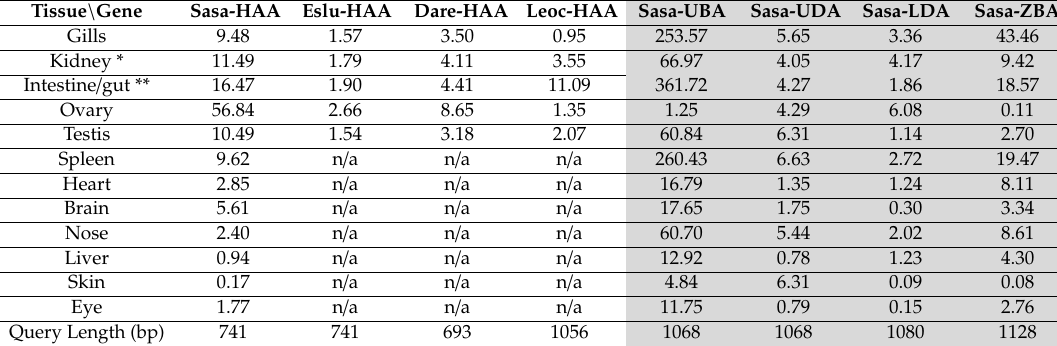
Table 1. HAA transcription in various tissues of several teleost fish species. Transcriptional values are given as RPKM, i.e., Reads Per Kilobase per Million mapped reads. See Materials and Methods section for dataset references. * Tissue denoted kidney is defined as head kidney in Atlantic salmon but as kidney in the other species. ** Intestine / gut is defined as gut in Atlantic salmon but as intestine in the other species. Atlantic salmon RPKM values in grey colored cells for the classical UBA locus and the nonclassical UDA , LDA , and ZBAa genes originate from our previous study